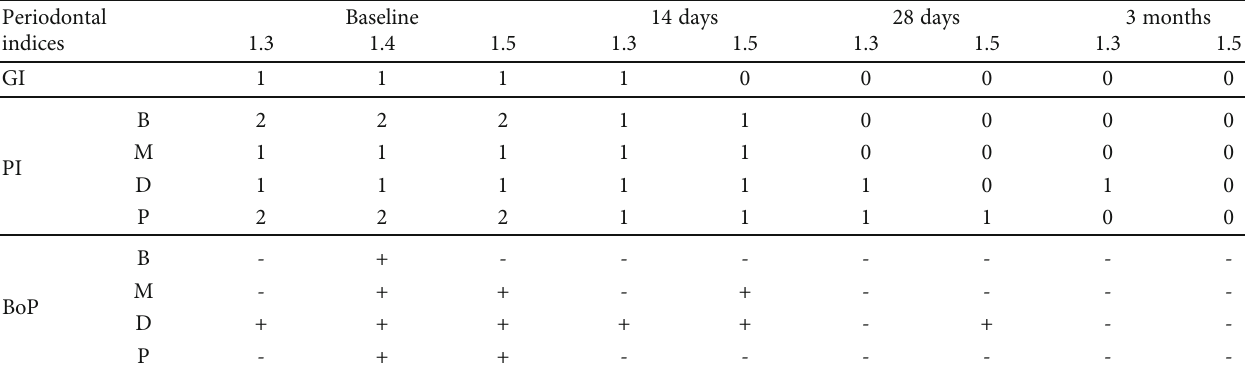
Table 1: Periodontal index measures.